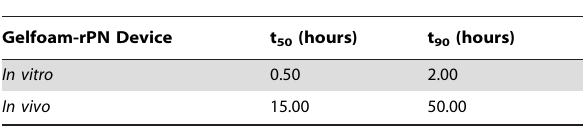
Table 1. Release